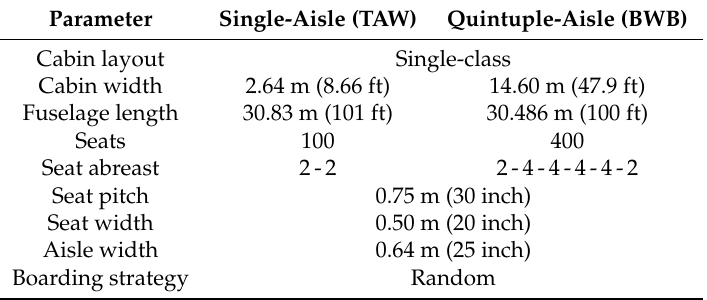
Table 3. Cabin layout characteristics for the reference cases. Data from [2,22]. BWB: blended wing body; TAW: tube and